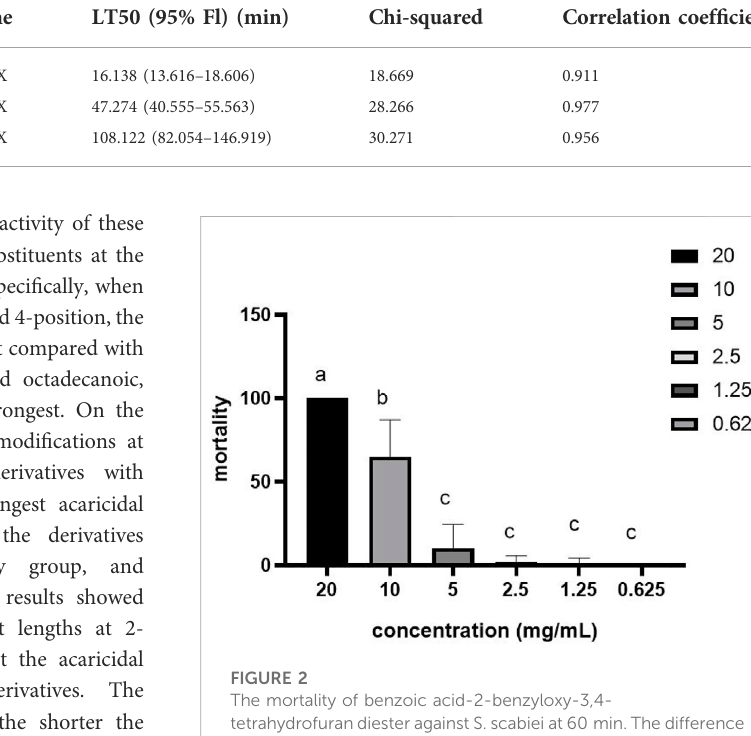
TABLE 2 The probit regression analysis of toxicity (LT50) of benzoic acid-2-benzyloxy-3,4-tetrahydrofuran diester against S. scabiei var. cuniculi larvae in vitro . Concentration (mg/ml)